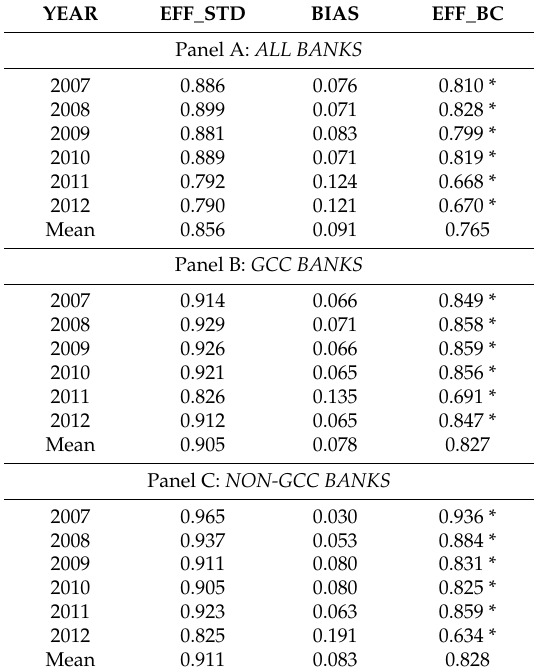
Table 2. Standard and bias-corrected overall technical efficiency